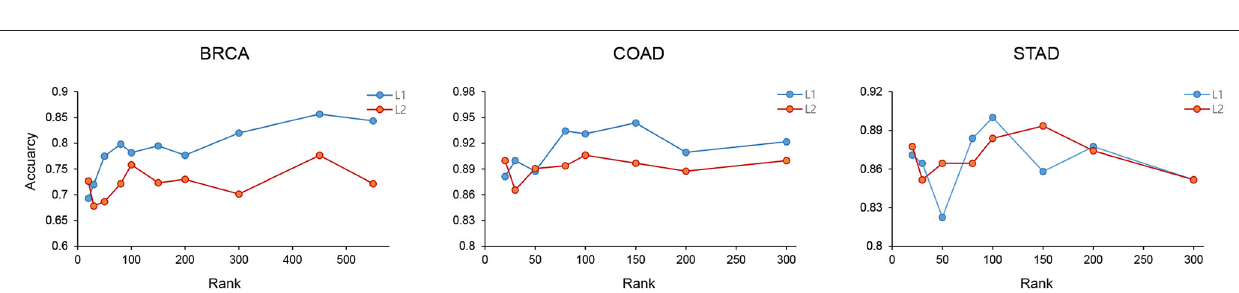
FIGURE 5 | The cancer subtype classification accuracy of BRCA, COAD, and STAD was measured using features selected by the L1 and L2 method with different